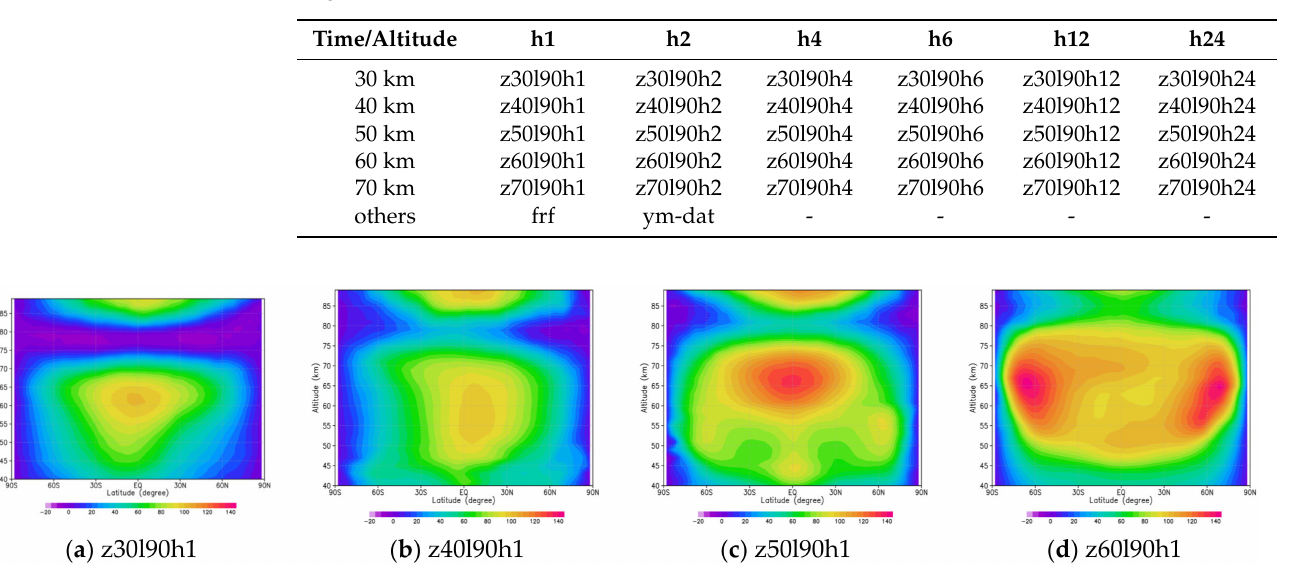
Table A1. Cases of idealized wind observations for observing system simulation experiments. Ideal-